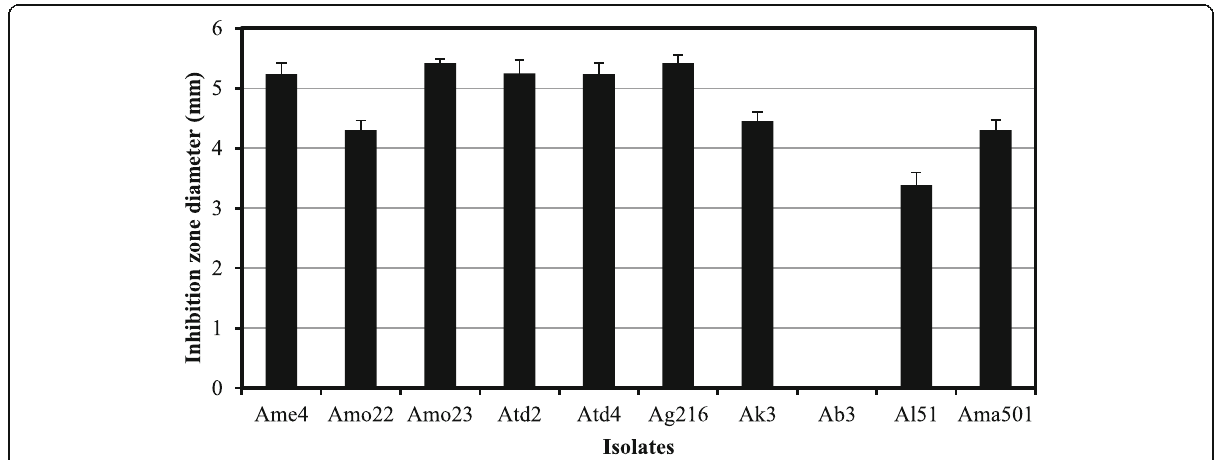
Fig. 3 Inhibitory effect of selected antagonists on the growth of the strain Pectobacterium carotovorum B 1158 T